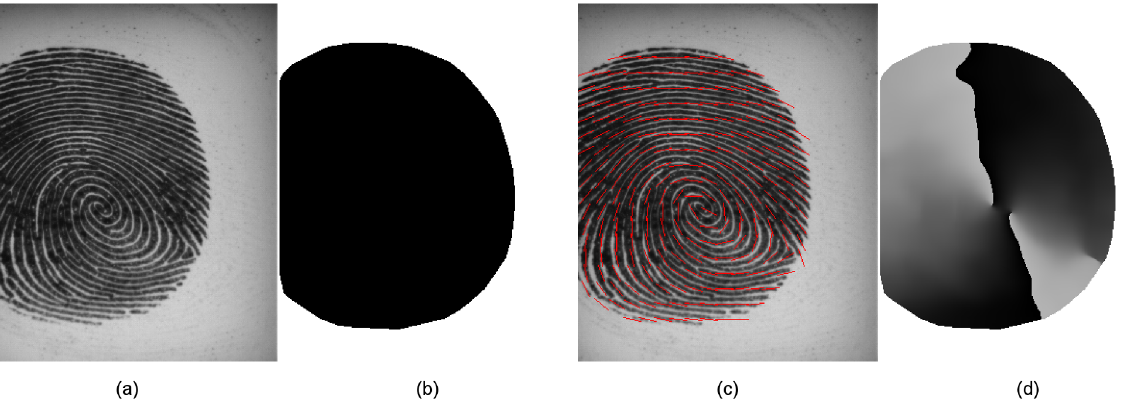
Fig 3. The preprocessing steps for an input fingerprint image (a) are segmentation (b)and orientation field (OF) estimation (c,d). Foreground pixels in (b) are shown in black, background pixels in white. The OF is visualized in (c) by red lines for every 16th pixel. In (d), orientations in degrees are encoded by gray values between 0 and 179, where 0 corresponds to x-axis and angles increase